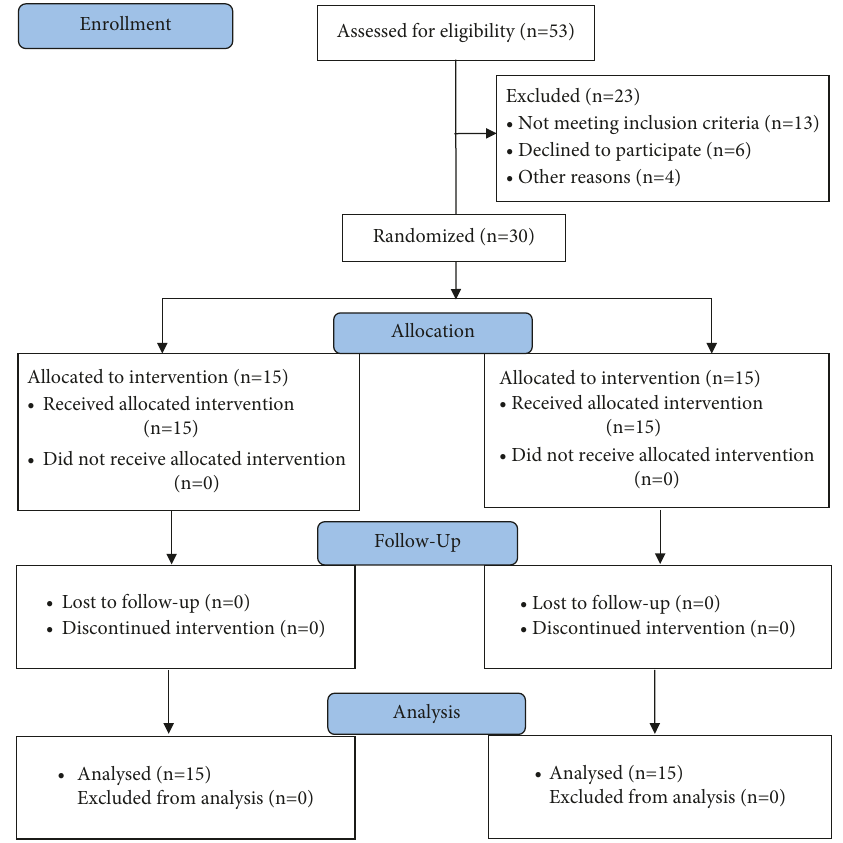
Figure 1: A CONSORT (2010) flow diagram including participants’ enrolment, allocation, follow-up, and analysis of